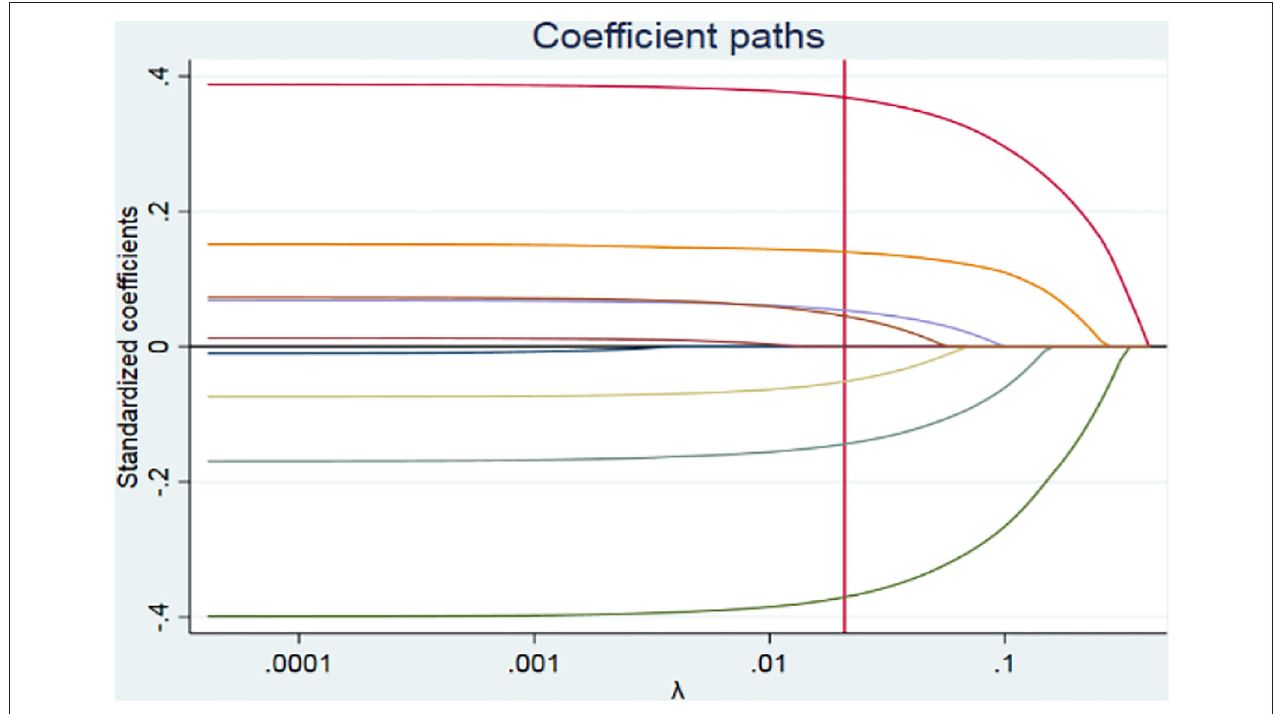
FIGURE 1 | Lasso regression coefficient